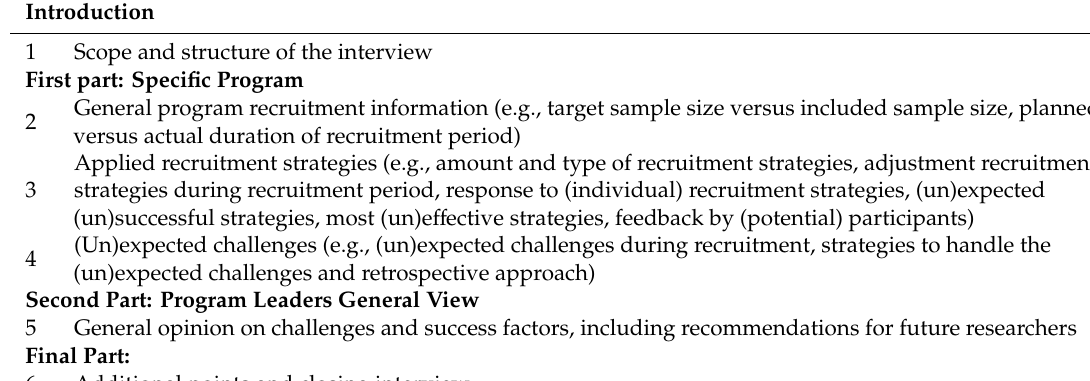
Table 1. Summary semi-structured interview